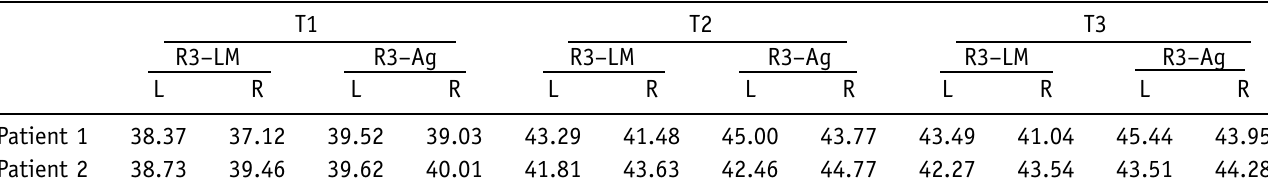
Table II. Posterior facial height measures (in